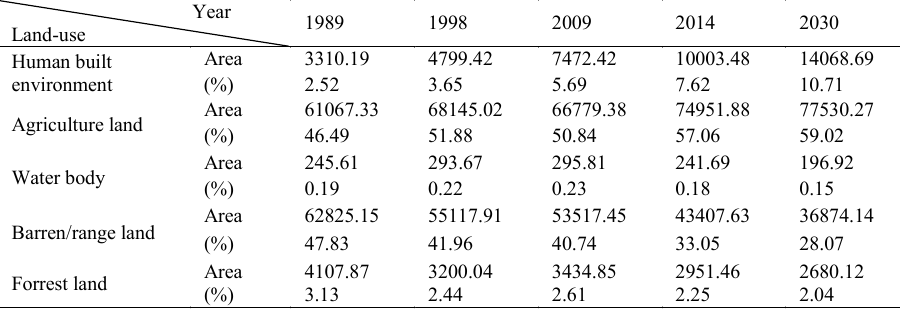
Table 2: Area (ha) and percentage of LULC type during the time span